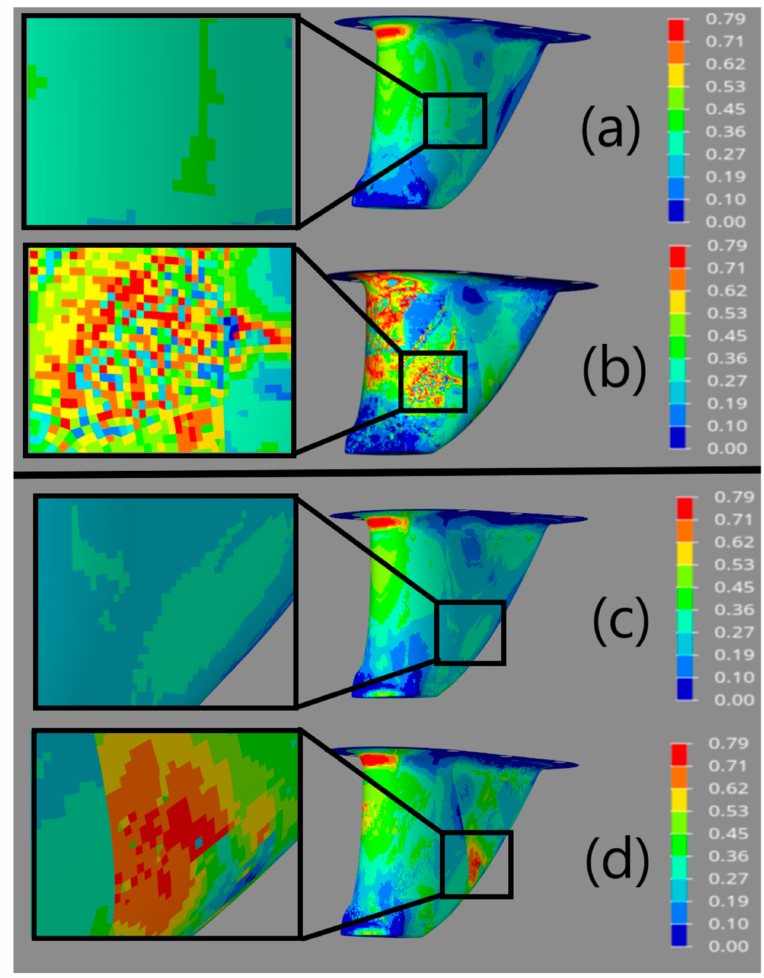
Figure 11. Maximum Stress failure criterion contour plots for optimized models ( a ) integral without draping; ( b ) integral with draping; ( c ) partitioned without draping; ( d ) partitioned with